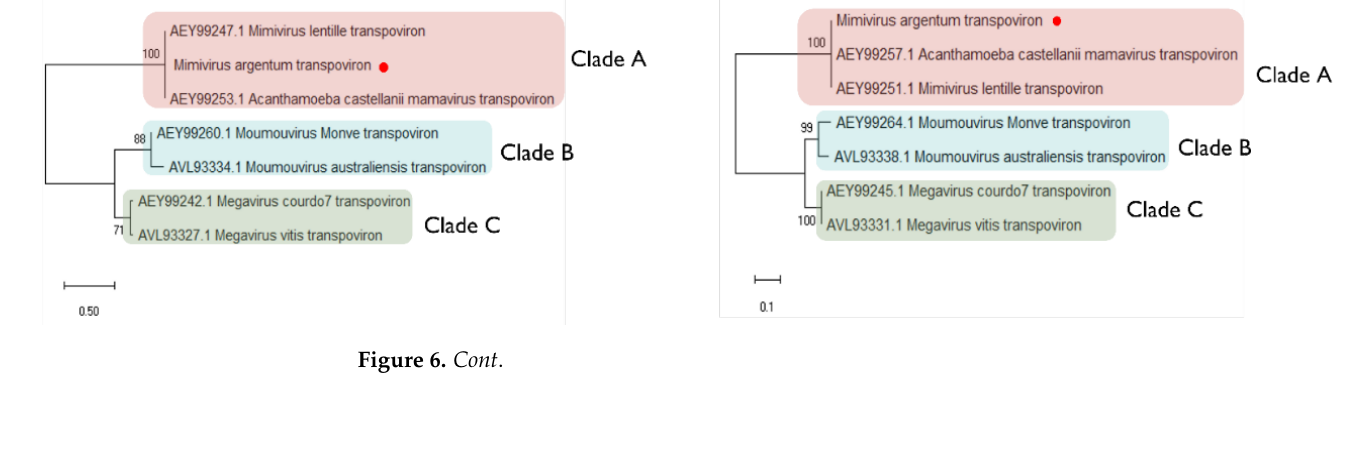
Figure 6. Phylogeny of three transpovirons core proteins. ( A – C ) Maximum-likelihood trees based on amino acid sequences from a hypothetical protein (ORF1), helicase domain-containing protein (ORF5), and zinc-finger containing protein (ORF6), respectively. The best-fit models chosen with ModelFinder (implemented in IQtree) for trees A, B, and C was JTTDCMut + F + G4, JTT + F + I, and VT, respectively. Mimivirus argentum transpoviron sequences are indicated by the red circle. Tree scale bars represent the number of amino acid substitutions per site. 4. Conclusions The first description of a mimivirus triggered the discovery of several groups of giant viruses, evidencing the wide diversity and ubiquity of these unique components of the virosphere. Giant virus prospecting studies are important because they facilitate the es- tablishment of the basic biology of these viruses. In this context, we obtained an overview of the isolated particles by TEM images, which was useful for identification and particle morphology characterization and to observe some aspects of the mimivirus-virophage replication cycle. These observations raised interest in deeper investigations about some mechanisms that are still not completely established, especially regarding the virophage replication cycle. Thus, more detailed studies considering, for example, different post-in- fection time points, could be helpful to expand the knowledge of this topic. Most of the virophages known to date as well as some mimiviruses and transpovirons are described from metagenomic or genomic studies. Thus, the isolation of mimivirus argentum and its associated virophage suggests that research into the isolation of virophages around the